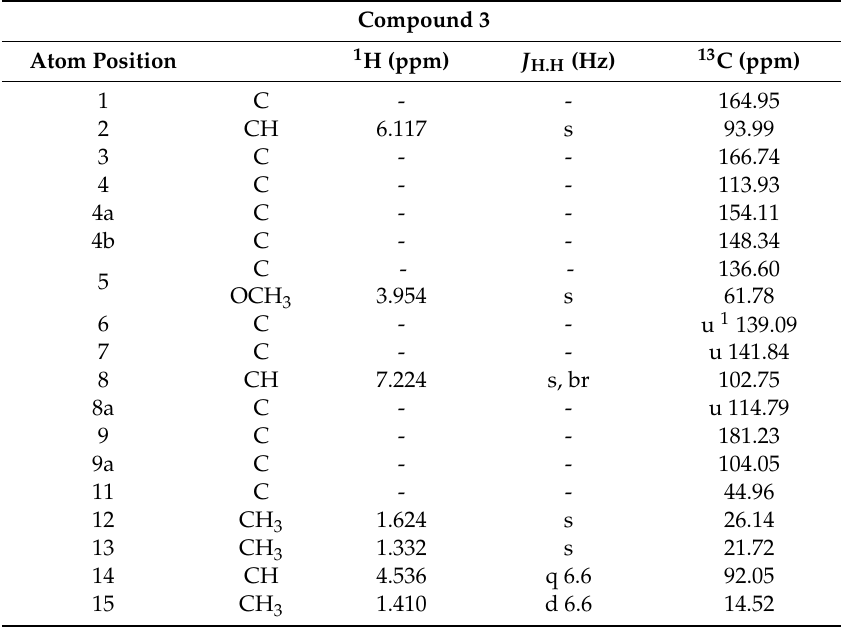
Table 3. 1 H- and 13 C-NMR data of compound 3 in CD 3